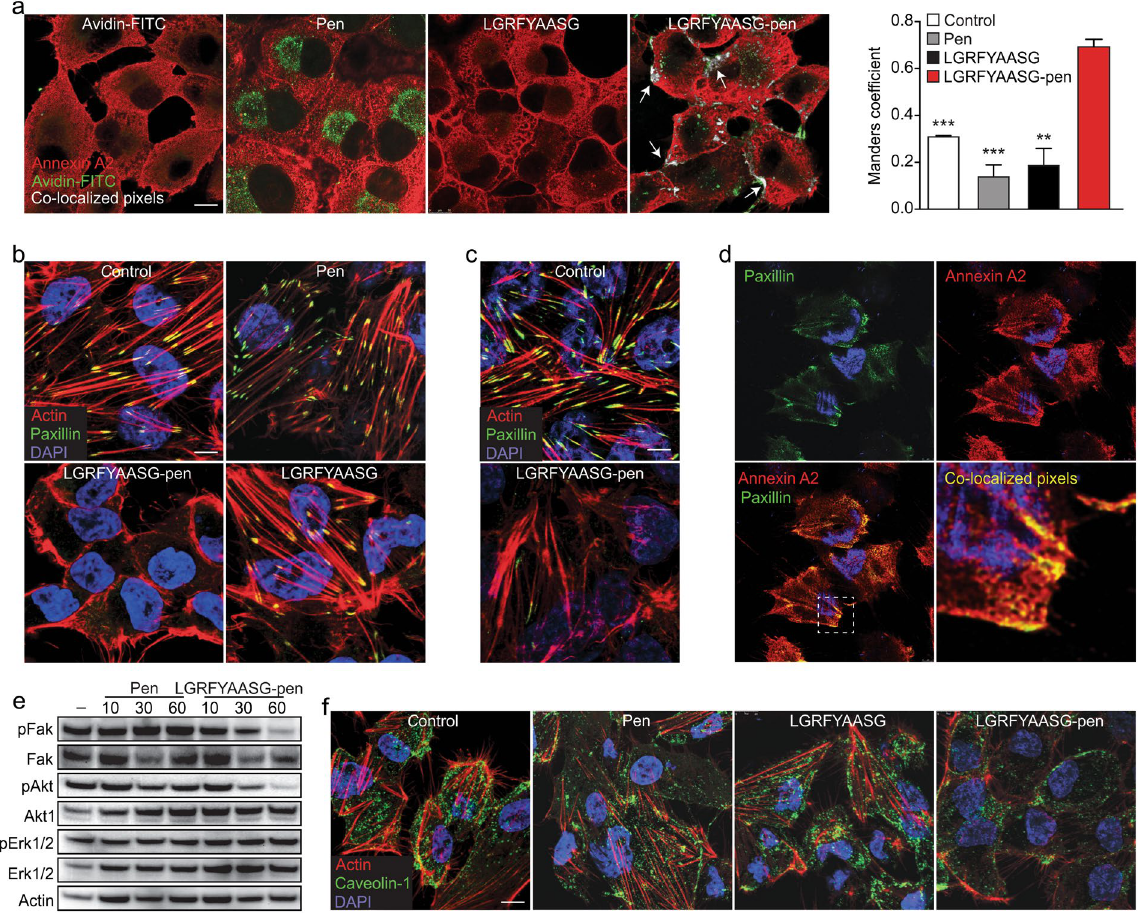
Figure 2. LGRFYAASG-pen co-localizes with annexin A2 and disrupts actin filaments, focal adhesions and caveolin-rich microdomains. ( a ) Co-localization analysis: KS1767 cells grown overnight onto circular coverslips were incubated for 2 h at 37 °C with biotinylated LGRFYAASG-pen, or unconjugated LGRFYAASG (10 µ M). Untreated cells were used as controls. IF staining of biotinylated peptides (avidin-FITC, green) and annexin A2 (Cy3-conjugated secondary antibody, red) was analyzed with Fiji ImageJ. Co-localized pixels are visualized in white (arrows), and Manders’ overlap coefficients are reported in the graph ( ** P < 0.01; *** P < 0.001 versus LGRFYAASG-pen). ( b , c ) Disassembly of actin filaments: IF staining of paxillin (FITC-conjugated secondary antibody, green) and actin (rhodamine-phalloidin, red) in KS1767 cells grown onto ( b ) fibronectin/vitronectin- or ( c ) type I collagen-coated coverslips. ( d ) Localization of annexin A2 at the focal adhesions: KS1767 cells co-stained for paxillin (FITC-conjugated secondary antibody, green) and annexin A2 (Alexa 647-conjugated secondary antibody, red). An enlarged inset (white dotted line) is included for prompt visualization. ( e ) Western blot of Fak, Akt and Erk1/2 phosphorylation following KS1767 cell incubation with pen only or LGRFYAASG- pen for the indicated periods of time. Total Fak, Akt, Erk1/2 were used as a reference, and actin served as loading control. ( f ) Disruption of caveolin-rich microdomains: KS1767 cells incubated with the peptides (30 µ M) followed by IF staining of caveolin-1 (FITC-conjugated secondary antibody, green) and actin (red). In ( b ), ( c ), ( d ), ( f ), nuclei are visualized with DAPI (blue); in all micrographs: scale bar, 10 µ